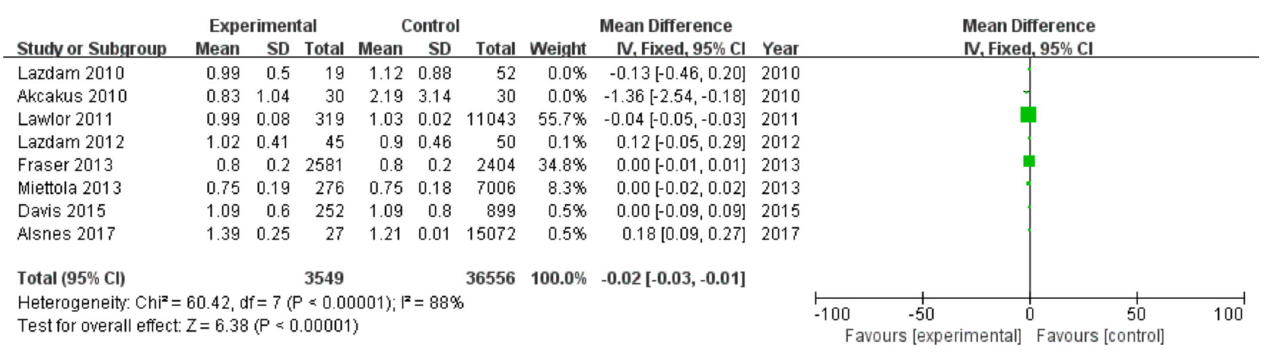
8 of 17 Figure 7. Meta ‐ analysis forest map for non ‐ HDL cholesterol of offspring of PE pregnancies. Law ‐ lor 2011, [20]; Alsnes 2014, [25]; Alsnes 2017, [28]. 3.2.7. Triglycerides Among 16 included studies, 8 studies investigated the triglycerides data of patients,